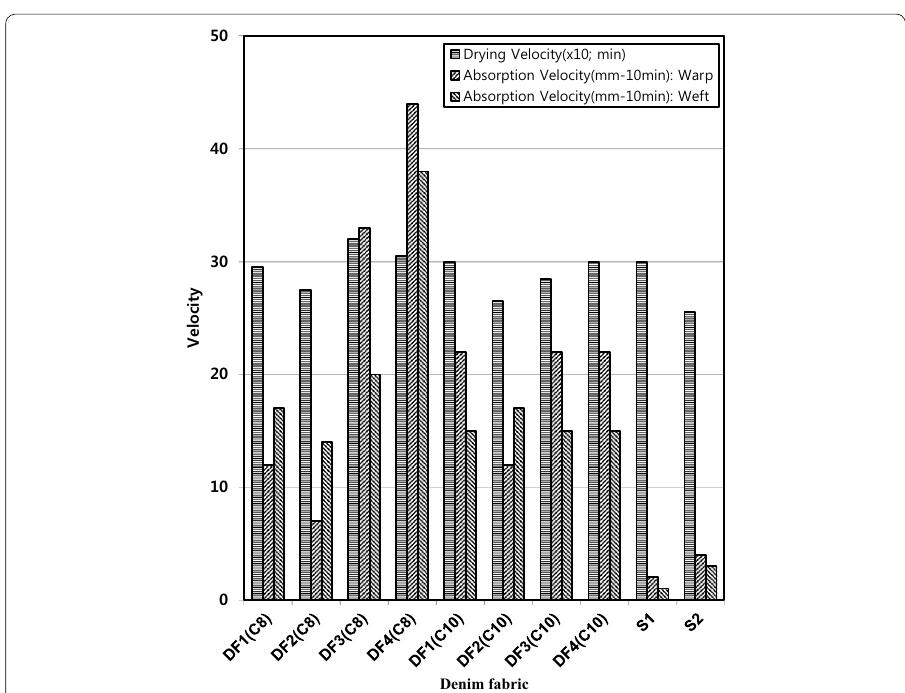
Fig. 6 Drying velocity and absorption velocity of Hanji denim